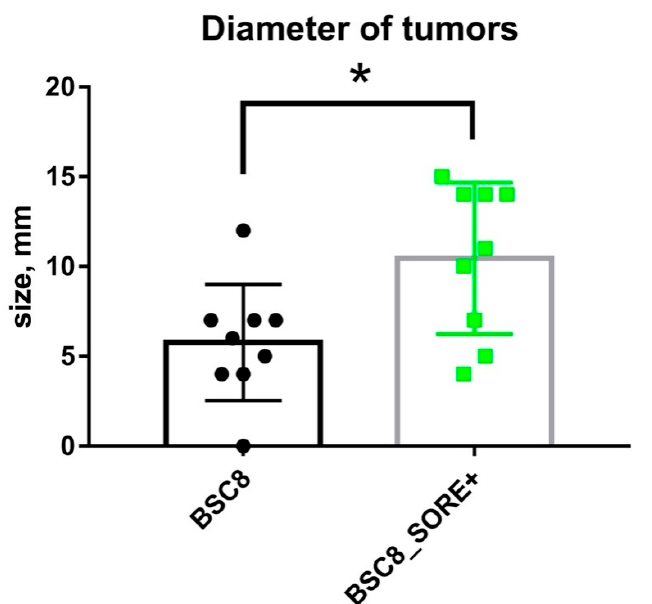
Figure 5. Comparison of the tumorogenic activity of the “stem-like” BSC8_SORE+ cells and original BSC8 cells, the sizes of tumors/measured in mice 40 days after the injection of BSC8_SORE+ cells and BSC8 are shown. Evaluation of the significance of the differences using the Student’s t -test showed that the sizes of tumors generated by BSC8 and BSC8_SORE+ cells significantly different on day 40, p < 0.01. * p < 0.05 for the difference.